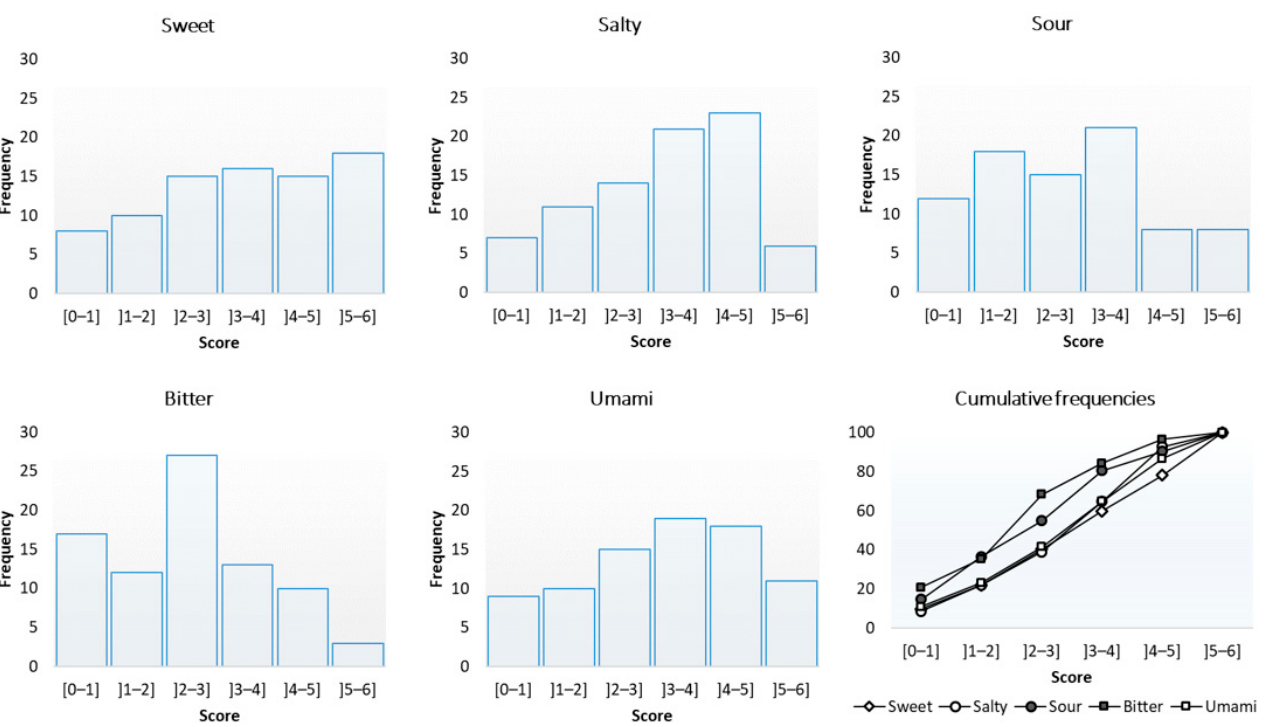
Figure 4. Distribution of taste sensitivity scores (82 subjects).